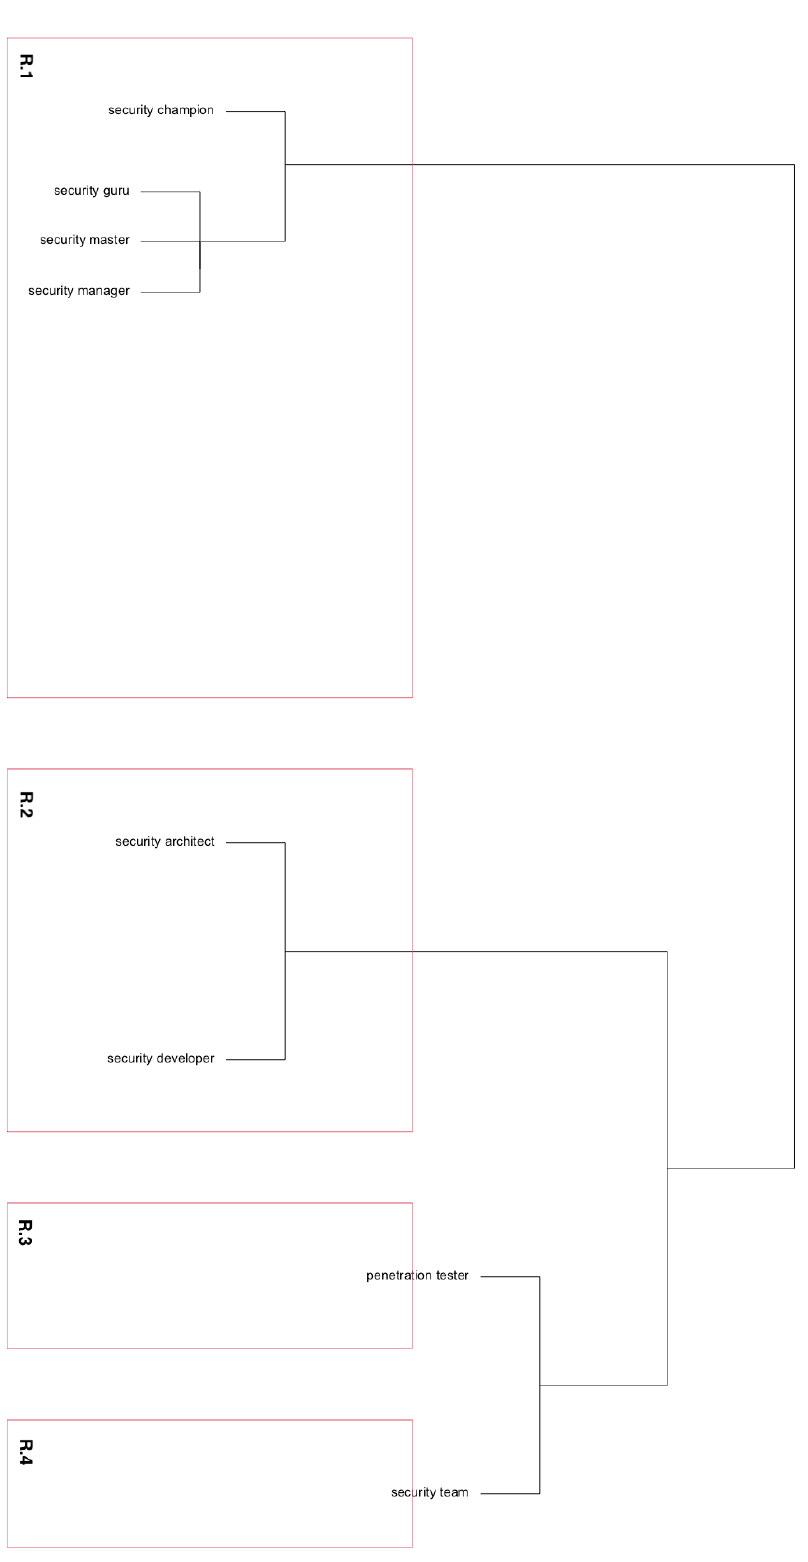
Figure 3. Dendrogram of roles. It indicates four distinct clusters: security guru (R.1), security developer (R.2), penetration tester (R.3), and security team